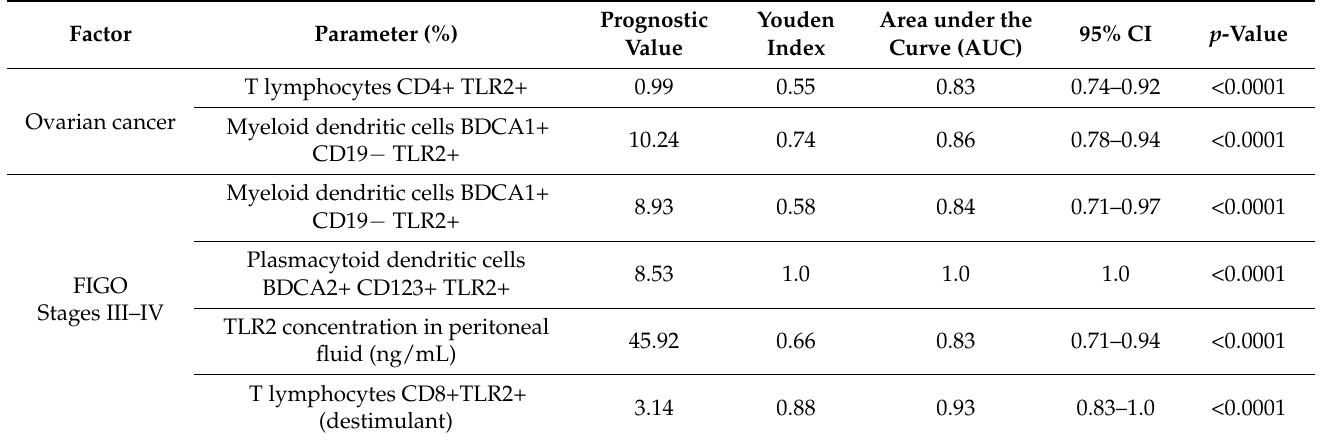
Table 3. Receiver operating curve (ROC) analysis to determine diagnostic accuracy in differentiation of patients with ovarian